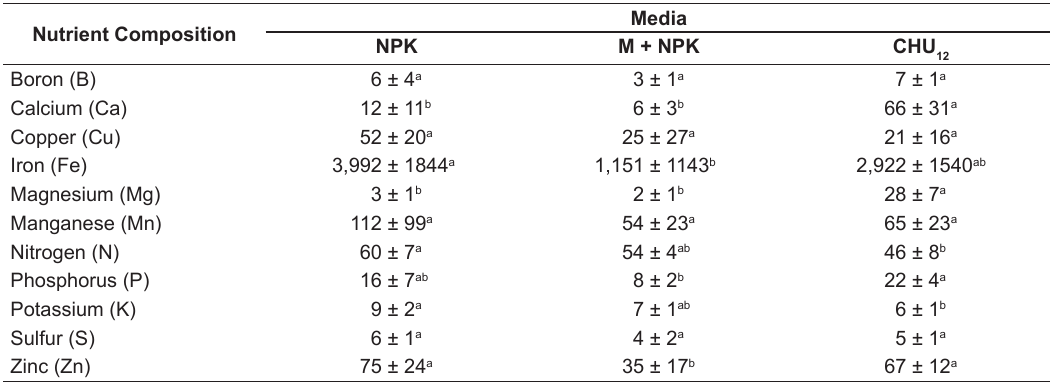
). Data represent 12 ). 12